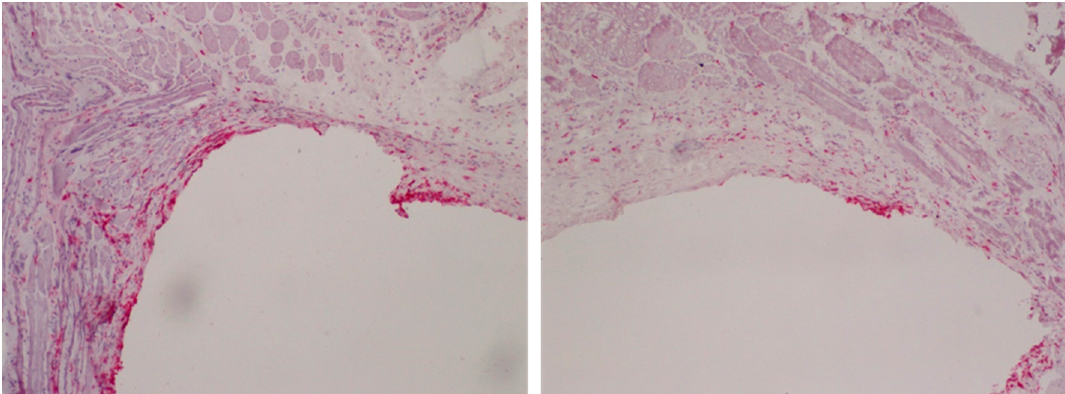
Figure 3. Total monocytes/macrophages (CD68 + ) in the peri-implant tissue 56 days after intramuscular implantation into rats of an unmodified Ti plate ( left ) vs. a PPAAm-coated Ti plate ( right ). Note the reduced macrophage response for PPAAm samples. Method: Peri-implant tissue samples were immediately shock-frozen after explantation and, following careful removal of the Ti plates, processed as cryosections (5 µm) and stained with monoclonal antibody ED1 (mouse anti-CD68); image magnification 125×.